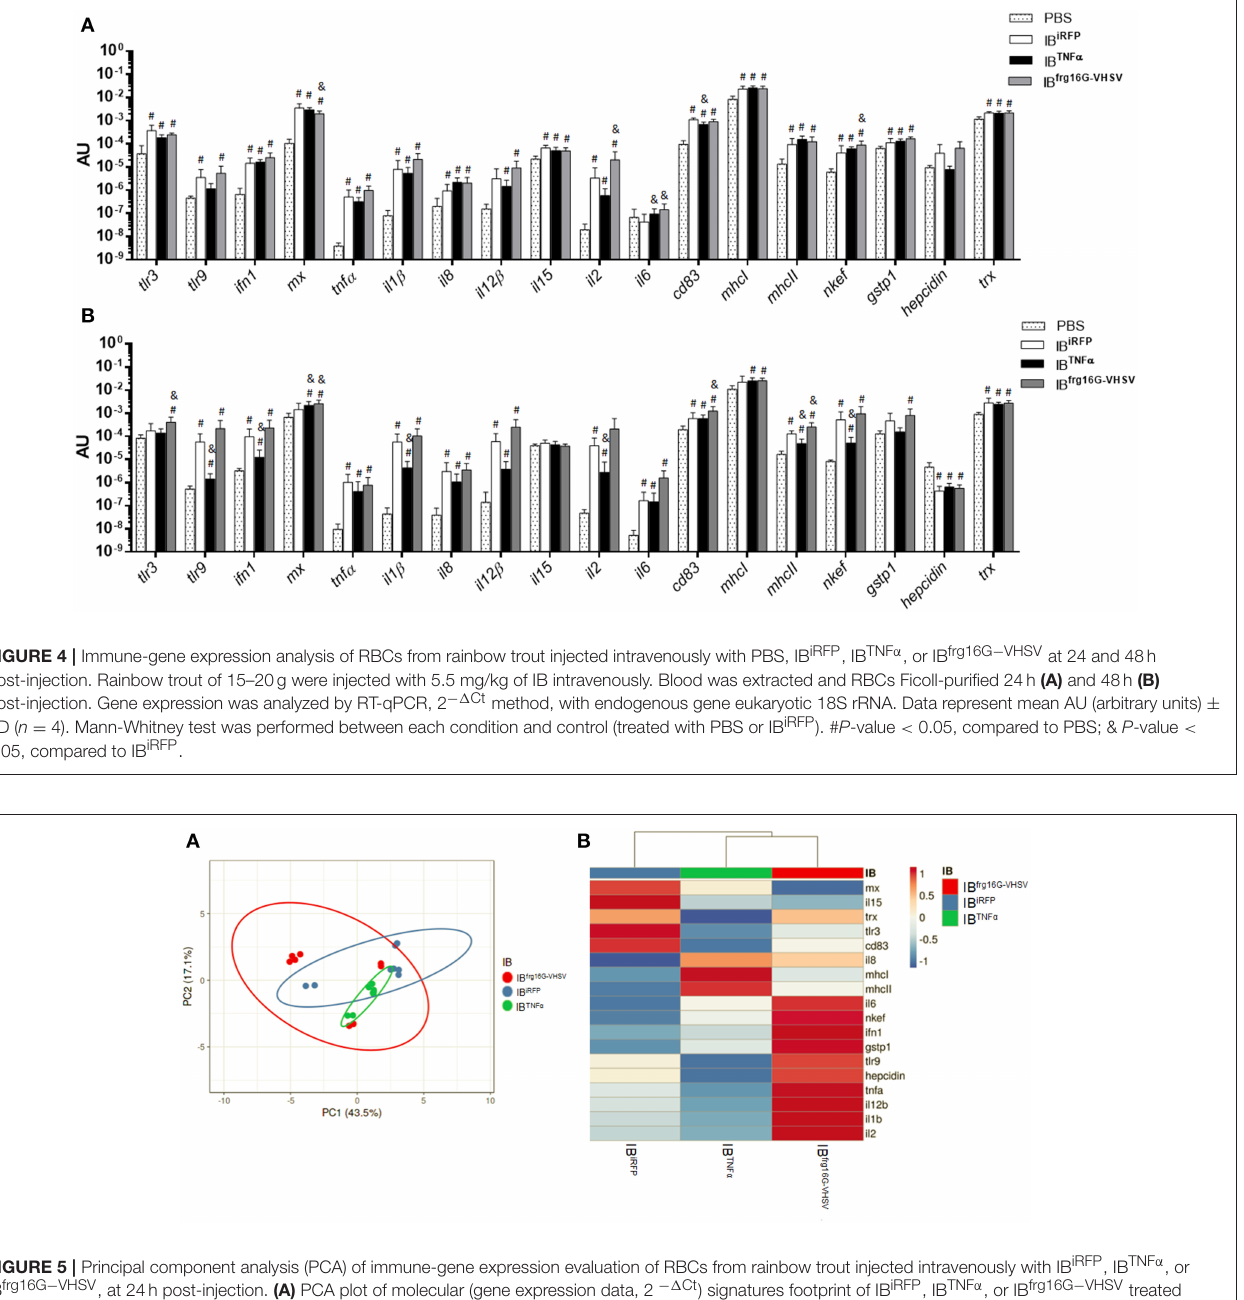
FIGURE 5 | Principal component analysis (PCA) of immune-gene expression evaluation of RBCs from rainbow trout injected intravenously with IB iRFP , IB TNF α , or IB frg16G − VHSV , at 24h post-injection. (A) PCA plot of molecular (gene expression data, 2 − 1 Ct ) signatures footprint of IB iRFP , IB TNF α , or IB frg16G − VHSV treated samples, at 24h post-injection. Ellipses and shapes show clustering of the samples. (B) Heatmap of gene expression (2 − 1 Ct ) signatures of IB iRFP , IB TNF α , or IB frg16G − VHSV treated samples. Annotations on top of the heatmap show clustering of the samples mean values. PCA plot and heatmap was performed using Clustvis software. Heatmap data matrix visualizes the values in the cells using a color gradient which gives an overview of the largest and smallest values in the